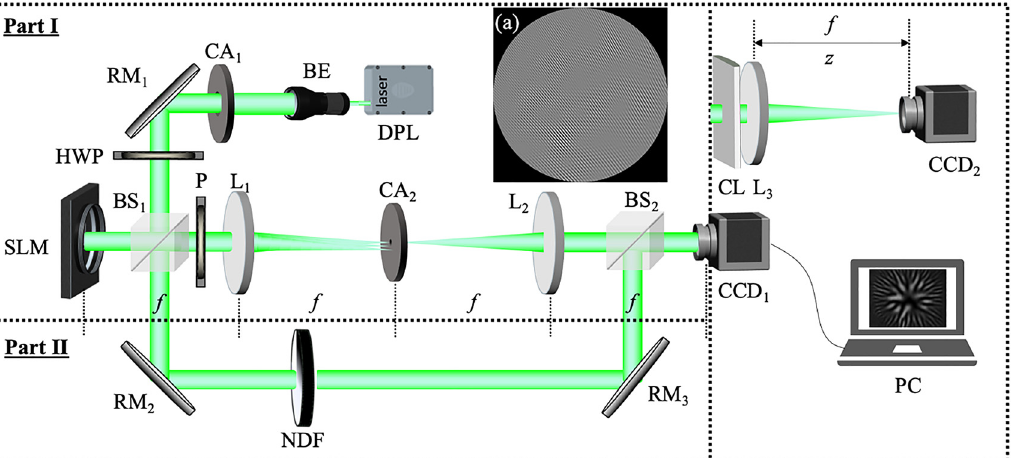
Figure 2: Experimental setup for synthesizing and measuring the TGSM beam with controllable twist phase. DPL, diode-pumped solid-state laser; BE, beam expander; CA 1 , CA 2 , circular apertures; RM 1 , RM 2 , RM 3 , re fl ect mirrors; HWP, half-wave plate; BS 1 , BS 2 , beam splitters; SLM, spatial light modulator; P, linear polarizer; L 1 , L 2 , L 3 , thin lenses; CL, cylindrical lens; NDF, neutral-density fi lter; PC, personal